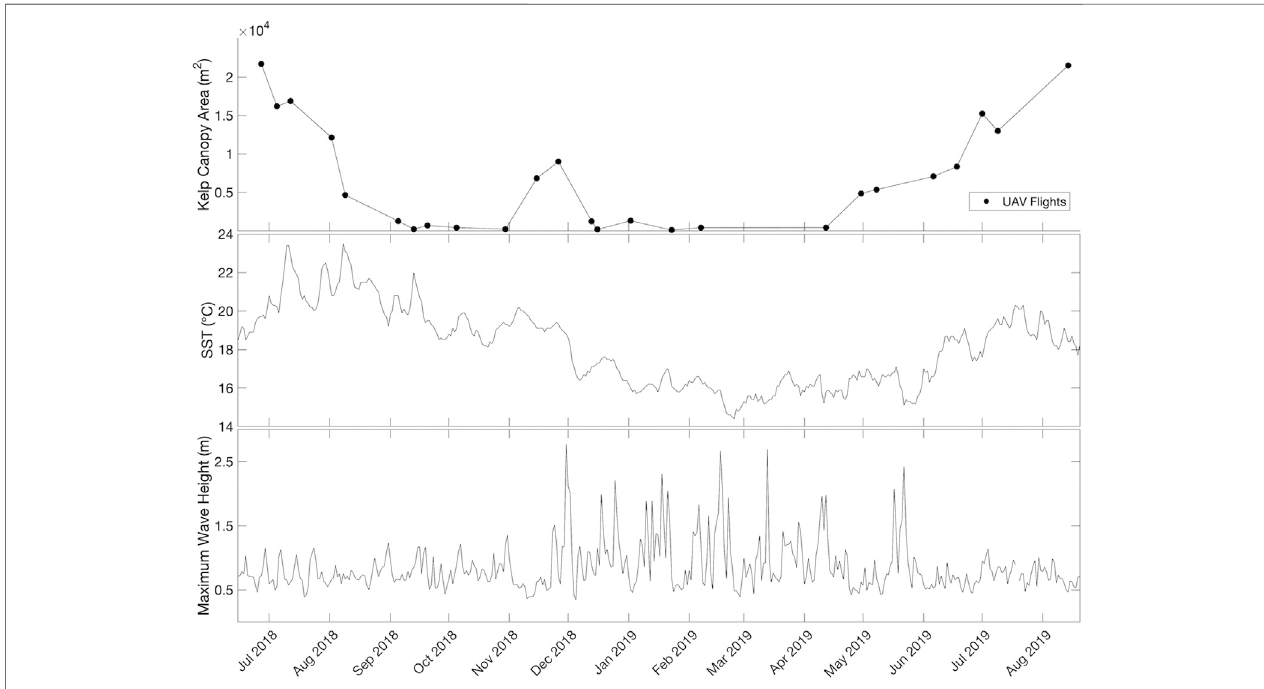
FIGURE 12 | Honeymoon Cove UAV-derived time series of kelp canopy area from June 2018 to August 2019.